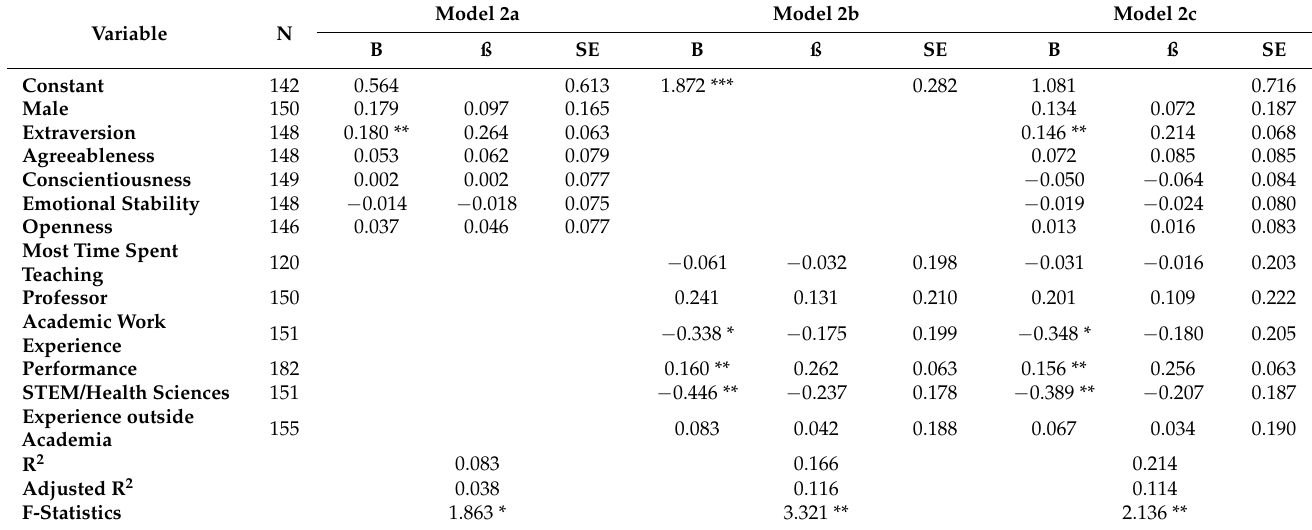
Table A2. Multiple regression models for predicting engagement in science communication.